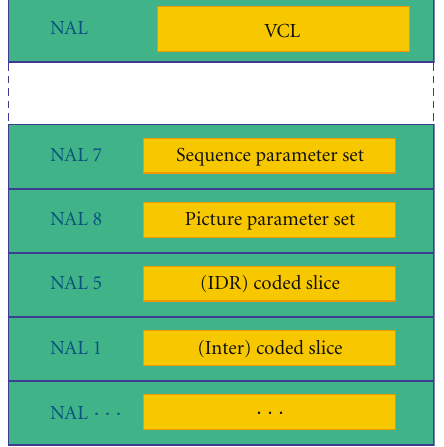
Figure 1: H.264 layer